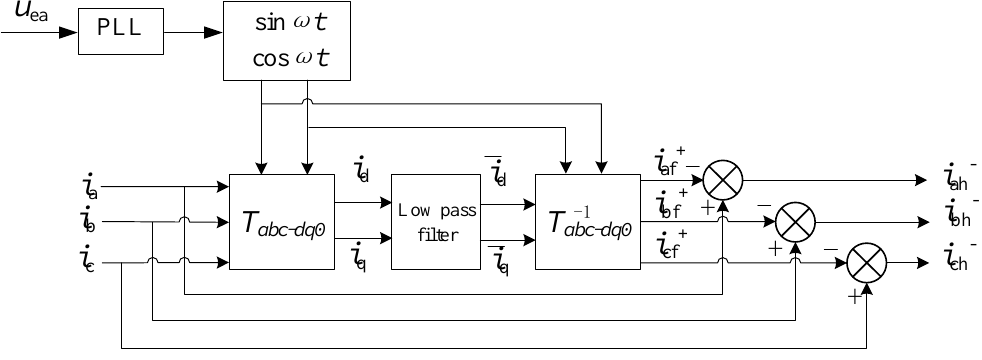
Figure 9. Harmonic detection